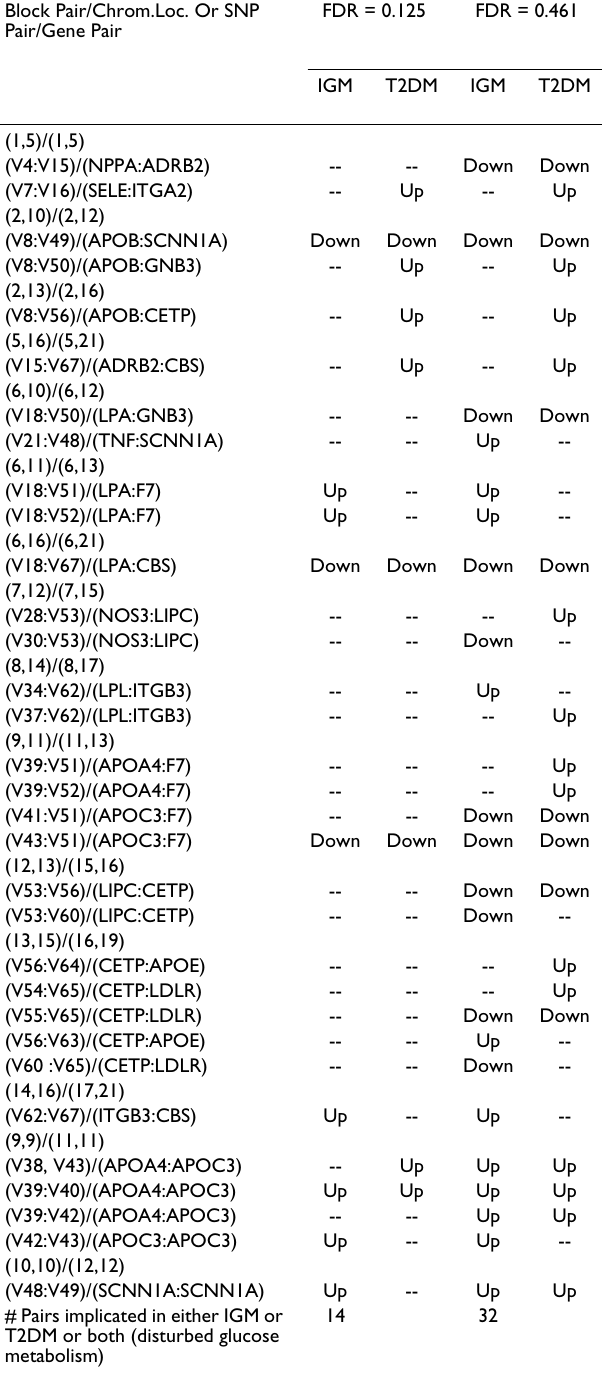
Table 6: Interactions between polymorphisms in genes that are associated with IGM or T2DM at the three FDR levels. Block Pair/Chrom.Loc. Or SNP Pair/Gene